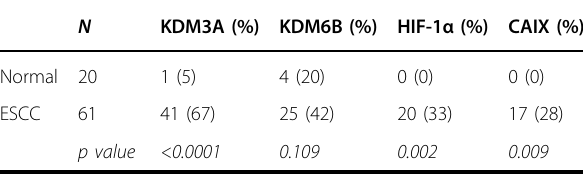
Table 1 KDMs and hypoxic markers positive expression in ESCC and normal